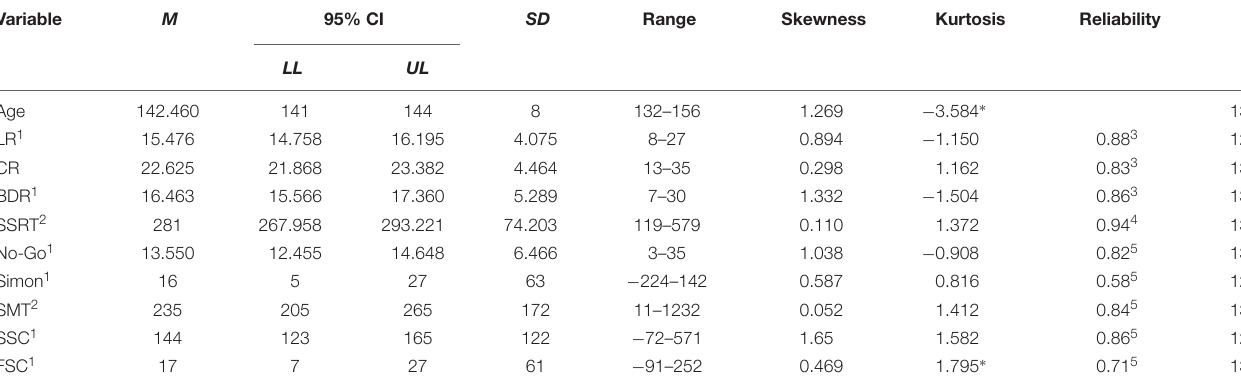
TABLE 4 | Descriptive statistics for the variables used in the current